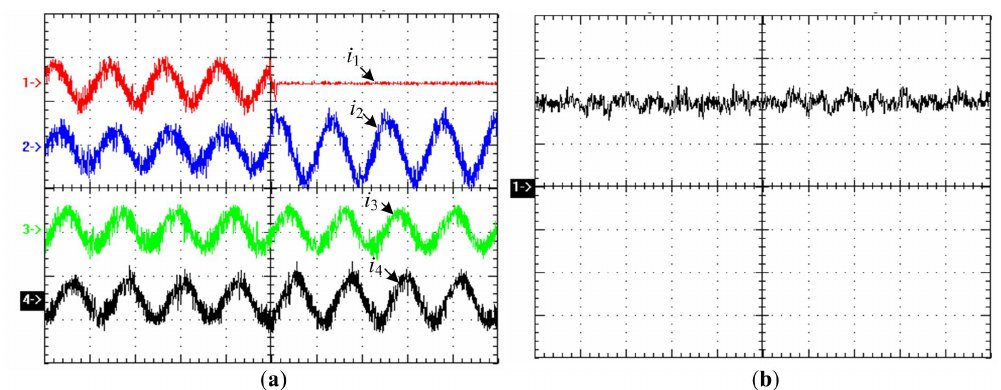
Figure 16. Experimental evaluation of post-fault operation performance. ( a ) (Traces 1–4) Measured phase current waveforms (5 ms/div, 5 A/div); ( b ) Measured torque (5 ms/div, 50